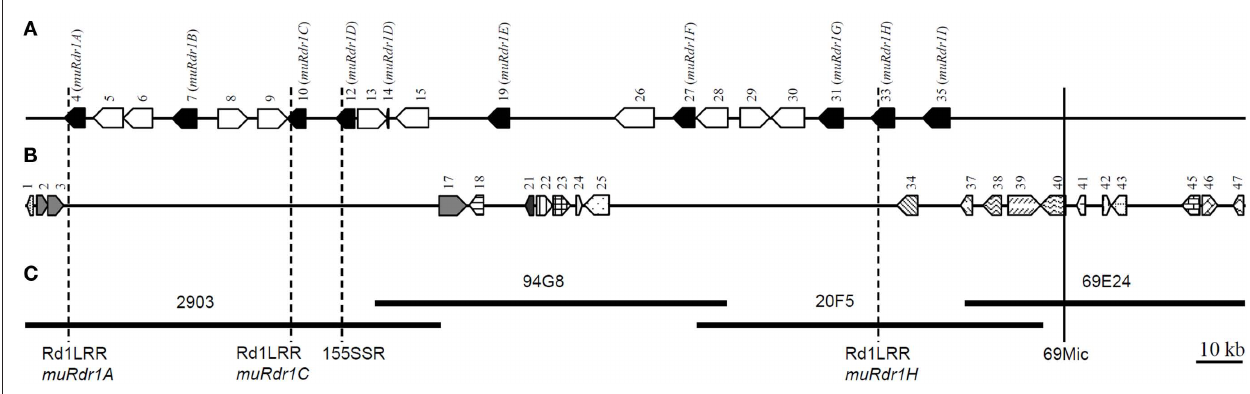
The broken-line indicates Rdr1 -linked SSR markers. The vertical unbroken line indicates recombination break point (69Mic) on the right side of the region. Numbers on each pentagon refer to the genes as described in Table 1 . Predicted genes without any similarity in the GenBank database are